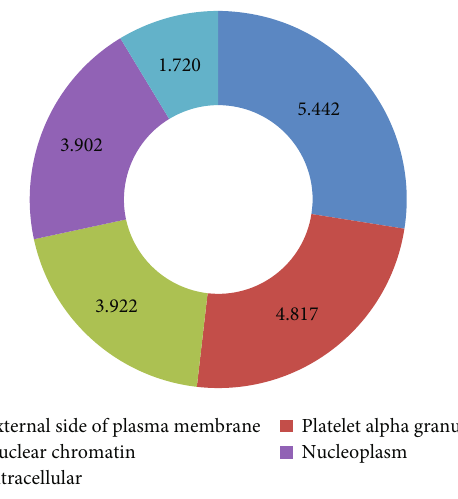
Figure 8: Enriched GO terms for the cell compound (CC) were analyzed by the DAVID system under the condition with P value < 0.05. The value in picture means − Log